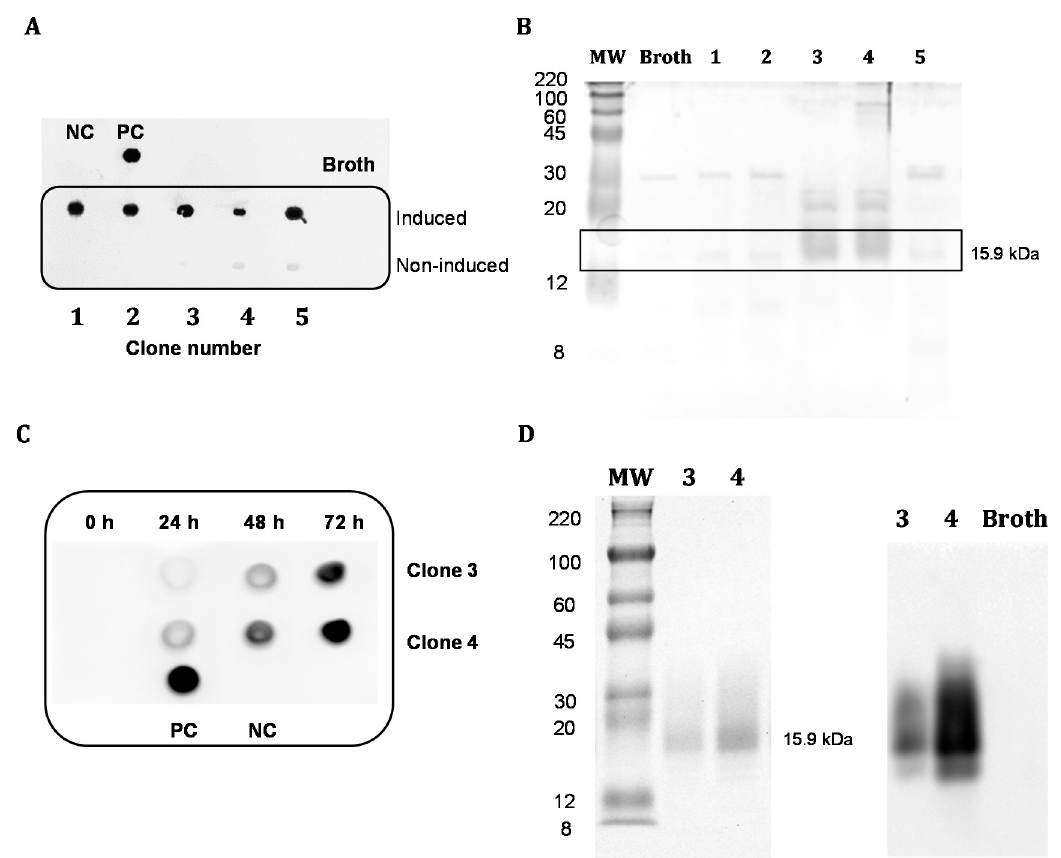
Figure 2. ( A ) Dot-blotting analysis of the small-scale production of five clones of P. pastoris transformed with pMJA302 (100 µL of the induced supernatants) revealed with a mouse monoclonal anti-c-myc antibody. The non-induced supernatants, broth media and PBS (NC) were analyzed as negative controls, and 1 µg of a previously purified scFv antibody fragment containing the c-myc epitope was included as positive control (PC). ( B ) Sodium dodecyl sulfate-polyacrylamide gel electrophoresis (SDS-PAGE) electrophoresis (under reducing conditions) of 10 µL of the above induced yeast cultures (lanes 1–5). ( C ) Dot-blotting analysis of the supernatants of two selected clones (clone 3 and 4) at 0, 24, 48 and 72 h of induction (10 µL of a 10-fold dilution of the supernatants). The PVDF membrane was revealed with a rabbit polyclonal anti-HisTag-HRP antibody. ( D ) SDS-PAGE ( left ) and Western Blot analysis ( right ) of 10 µL of the supernatants from clones 3 and 4 transformed with pMJA302 (lanes 3 and 4). The transferred proteins were revealed with the anti-HisTag-HRP antibody. In all cases MW (molecular weight marker) corresponds to the ColorBurst Electrophoresis Marker (Sigma-Aldrich).